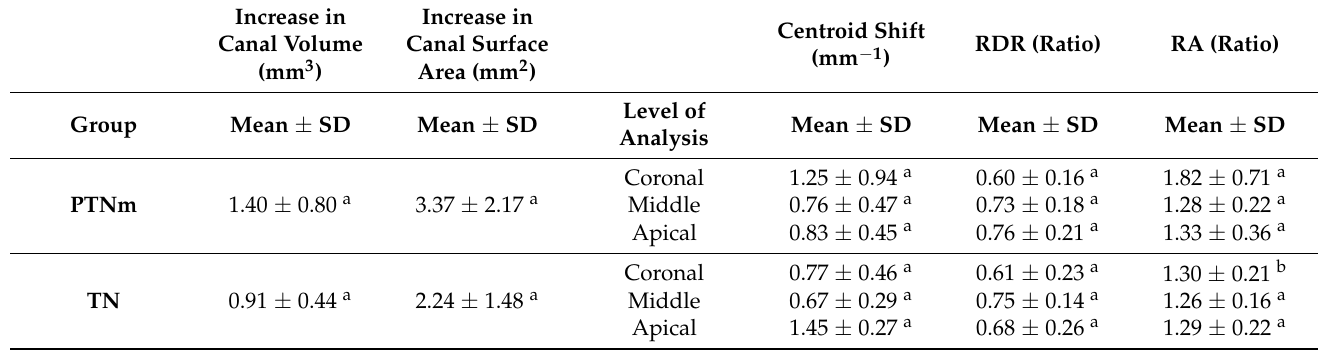
Table 2. 3D and 2D parameters utilized for post-shaping analysis in each group. Different superscript letters indicate statistical significance: a,b p < 0.05. For 2D parameters (centroid shift, RDR, and RA) significance was compared for the same level of analysis (coronal, middle, or apical). PTNm, modified ProTaper Next technique; RA, Ratio of Cross-Sectional Areas; RDR, Ratio of Diameters Ratios; TN, TruNatomy